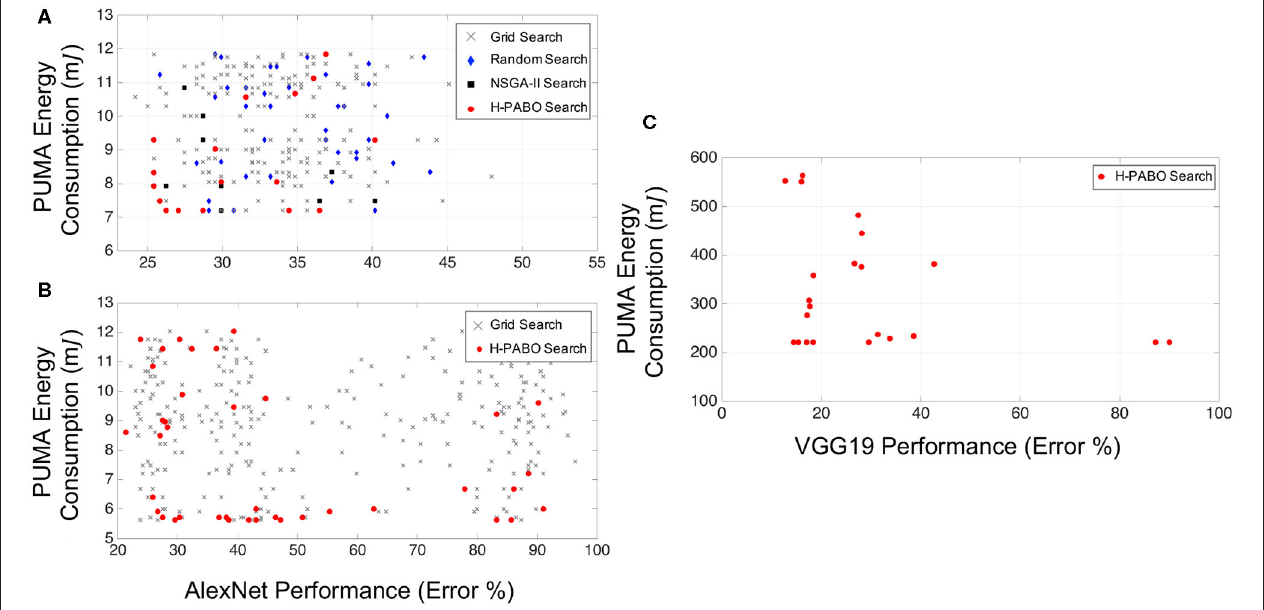
FIGURE 4 | ANN results for multi-objective hyperparameter optimization of network performance and hardware energy requirement. (A) Case study one: HP search space = 192, Reproduced with permission from Parsa et al. (2019a). (B) Case study two: HP search space = 288. (C) Case study three: HP search space = 3,072, Reproduced with permission from Parsa et al. (2019a).